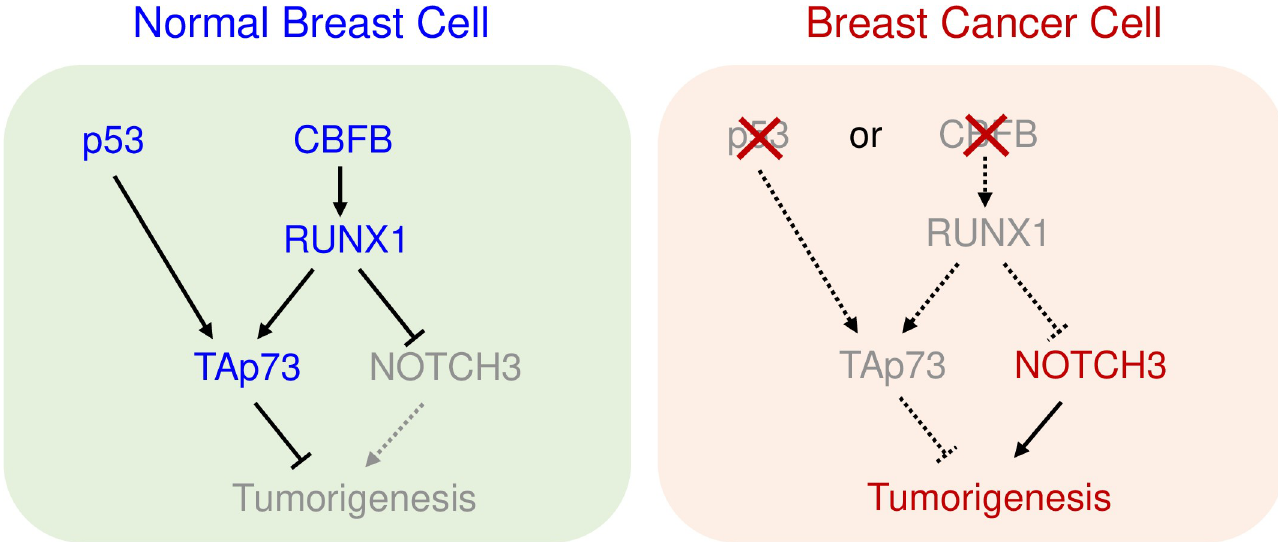
Fig 7. A model shows the functional interaction between the CBFB and p53 in breast tumor suppression. In normal breast cells, p53 and CBFB cooperatively maintain the expression of TAp73. In breast cancer cells, either CBFB loss or p53 loss reduces the levels of TAp73, which contributes to breast cell transformation and tumorigenesis by cooperating with NOTCH3 overexpression. TAp73 is one of the mechanisms underlying the functional interaction between CBFB and p53. Grey: loss or reduced activity; dashed lines: dysregulation; Arrows; induction; hammerheads: repression.